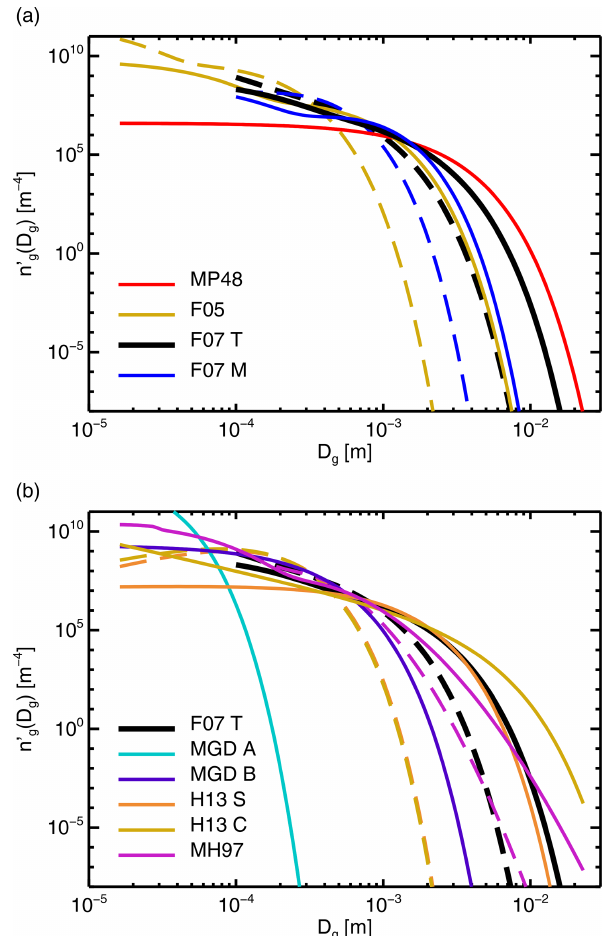
Figure 4. Examples of PSDs for frozen hydrometeors available in RTTOV-SCATT, using an ARTS large plate aggregate ( m = 0 . 21 D 2 . 26 g (SI) ) , an ice water content of 1 × 10 − 4 kgm − 3 , and tem- peratures of 223K (dashed) and 263K (solid). PSDs have been split across two panels for clarity, but for reference F07 T is present in both. At 223K, the H13 S and H13 C distributions are nearly iden- tical below n (cid:48) g (D g ) = 10 7 m − 4 . See Table 4 for PSD name abbrevi- ations. PSDs have been renormalised (Sect. 3.2.2) and all have been integrated using the new approach (Sect.